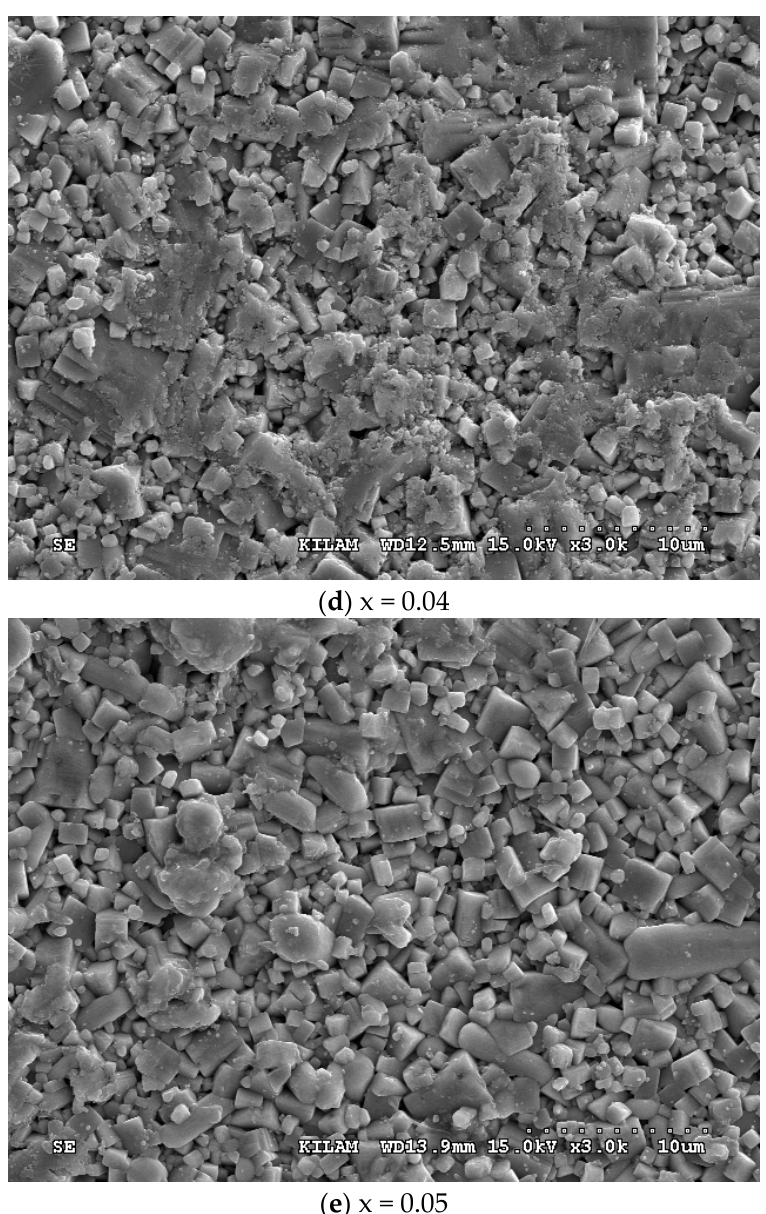
Figure 2. Scanning electron microscopy (SEM) of specimens with x (( a ) x = 0; ( b ) x = 0.02; ( c ) x = 0.03; ( d ) x = 0.04; ( e ) x = 0.05).